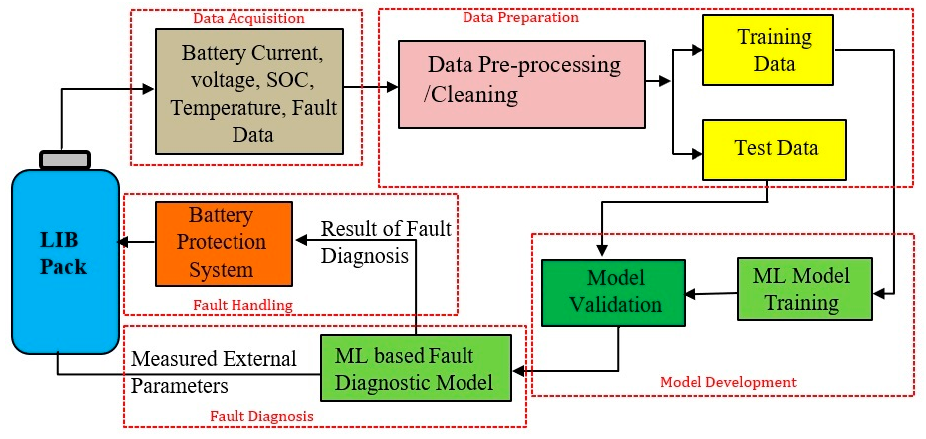
Figure 2. Generic block-diagram of ML-based fault diagnosis scheme .